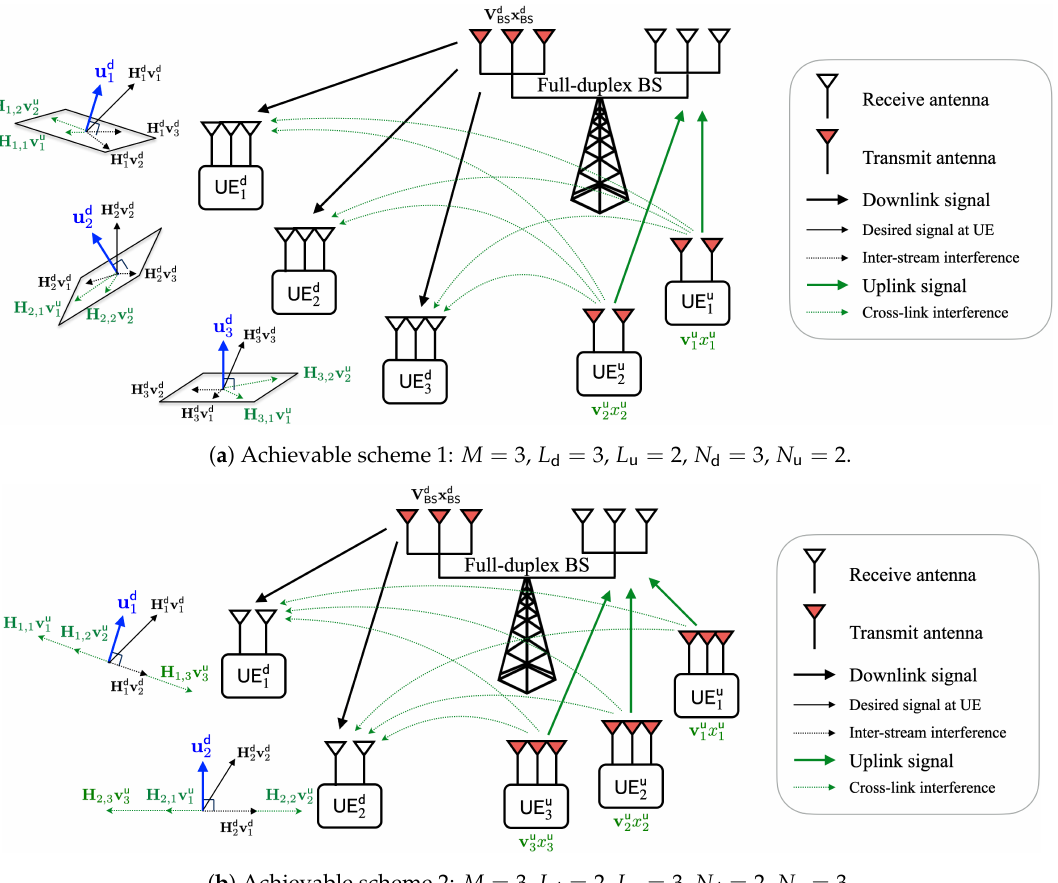
Figure 2. Geometric interpretation of the proposed IA schemes in IBFD MIMO